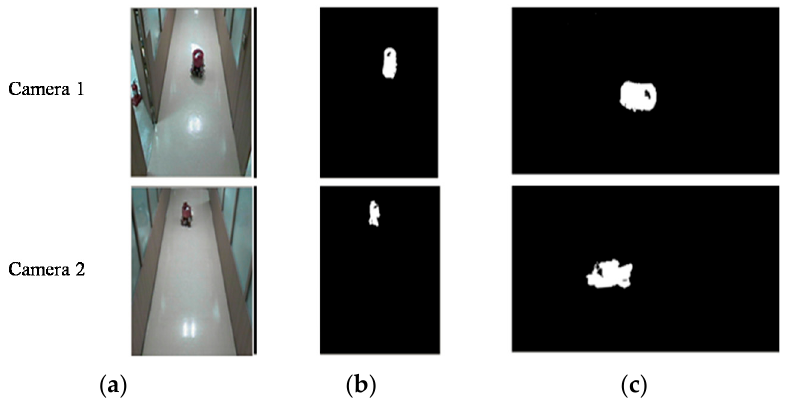
Figure 5. Projected images of two surveillance cameras by homography. ( a ) Original images; ( b ) Binary images; ( c ) Projected images.